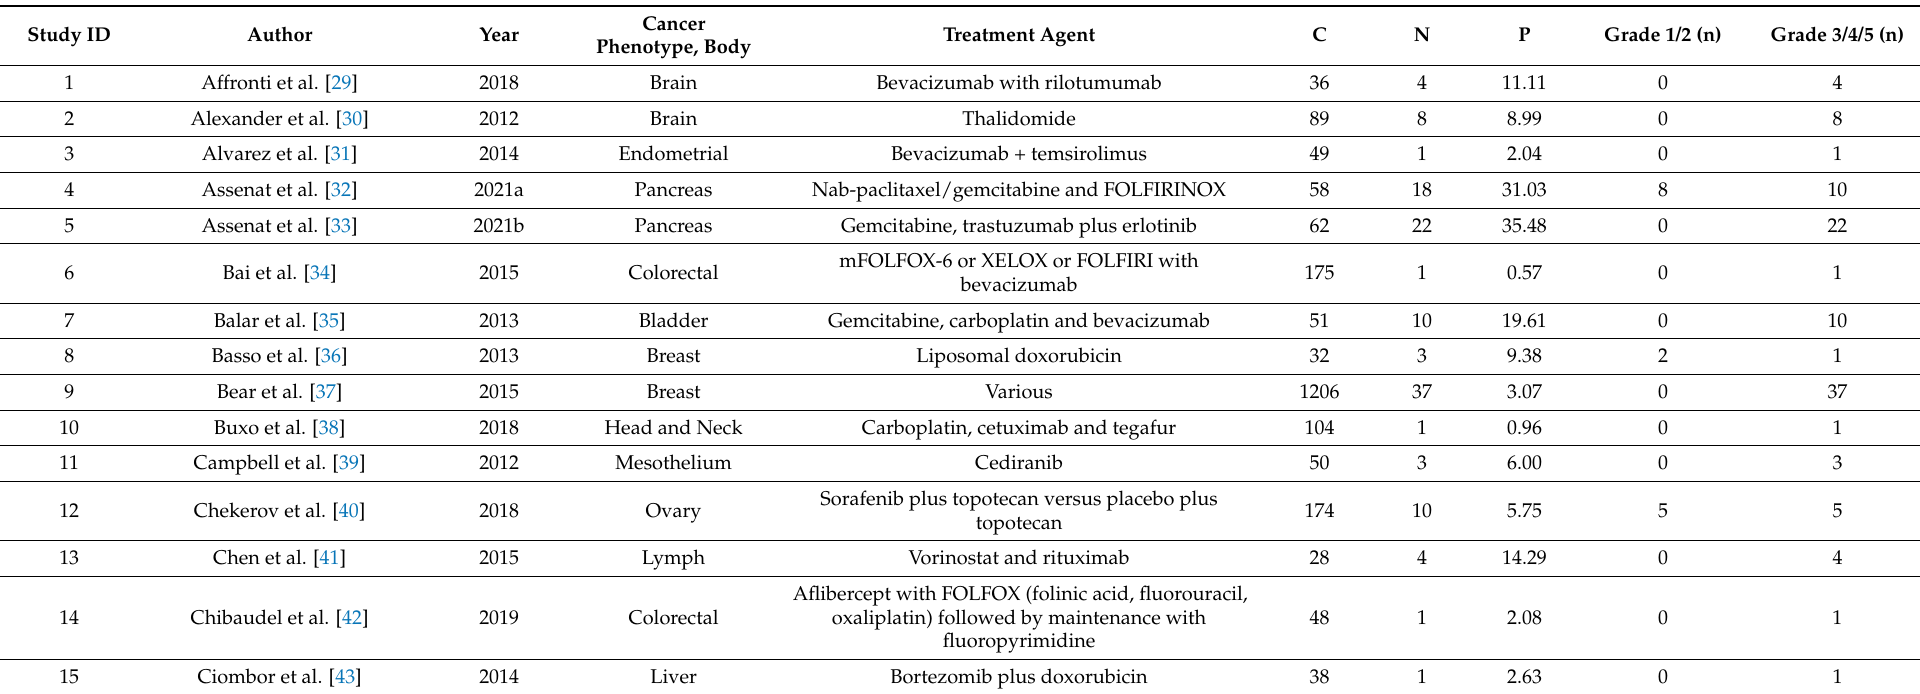
Table 2. Prevalence of venous thromboembolism stratified by treatment